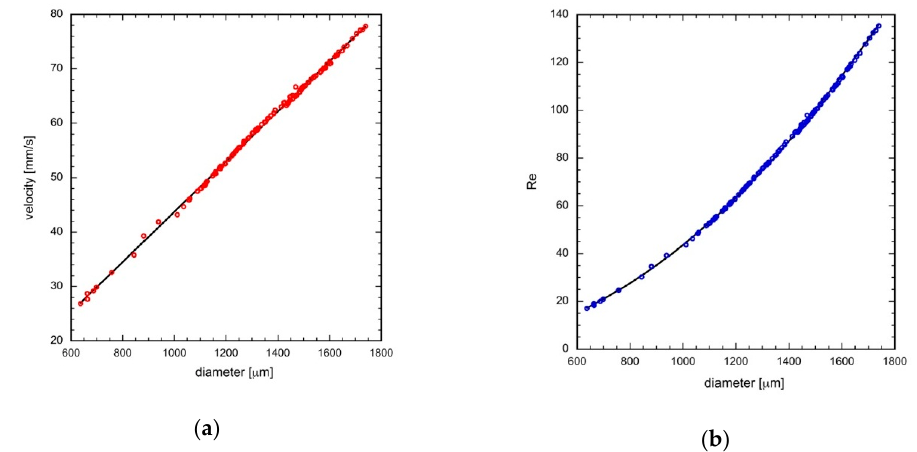
Figure 4. Dependence of ( a ) single droplet terminal velocity; ( b ) Reynolds numbers on droplet diameter (points–experimentally determined values, line—theoretical predictions, according to Equations (3)–(5)). Table 1. Physical parameters of the oil (dodecane) and water.